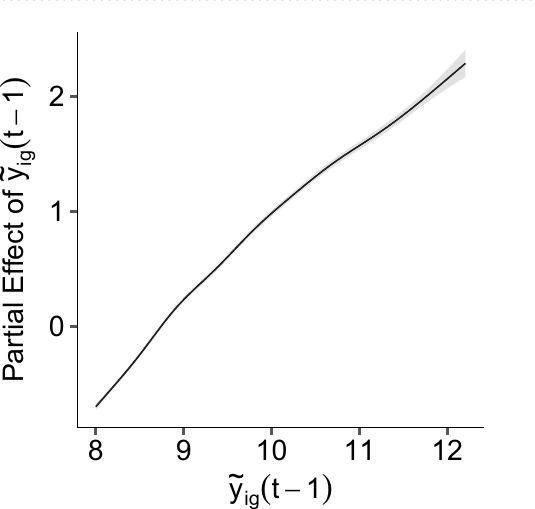
Figure 5. Left: average absolute error incurred by the ensemble for increasing levels of epistemic uncertainty, with vertical bars denoting ± one standard error of the estimation. Right: Standard error of the predictions of an ensemble of ten networks correlated with the error incurred when using the ensemble’s mean prediction for each district, age, and gender cohort during a low-infection phase (week 30) and the second wave of infections (week 44)